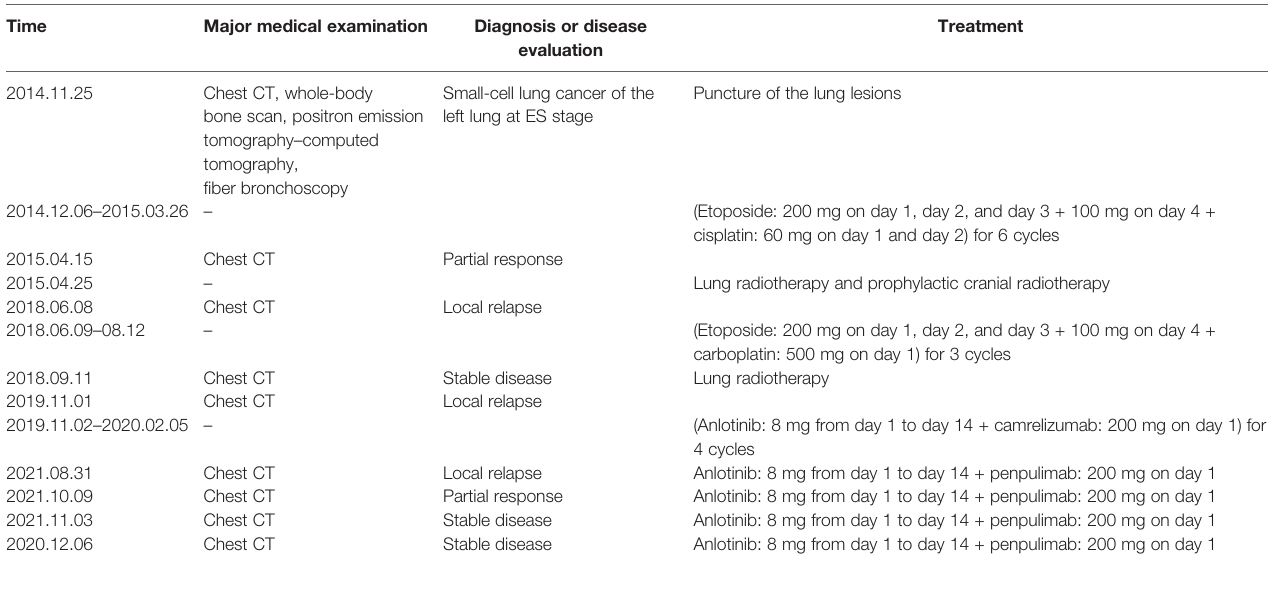
TABLE 1 | Timeline of the treatment.